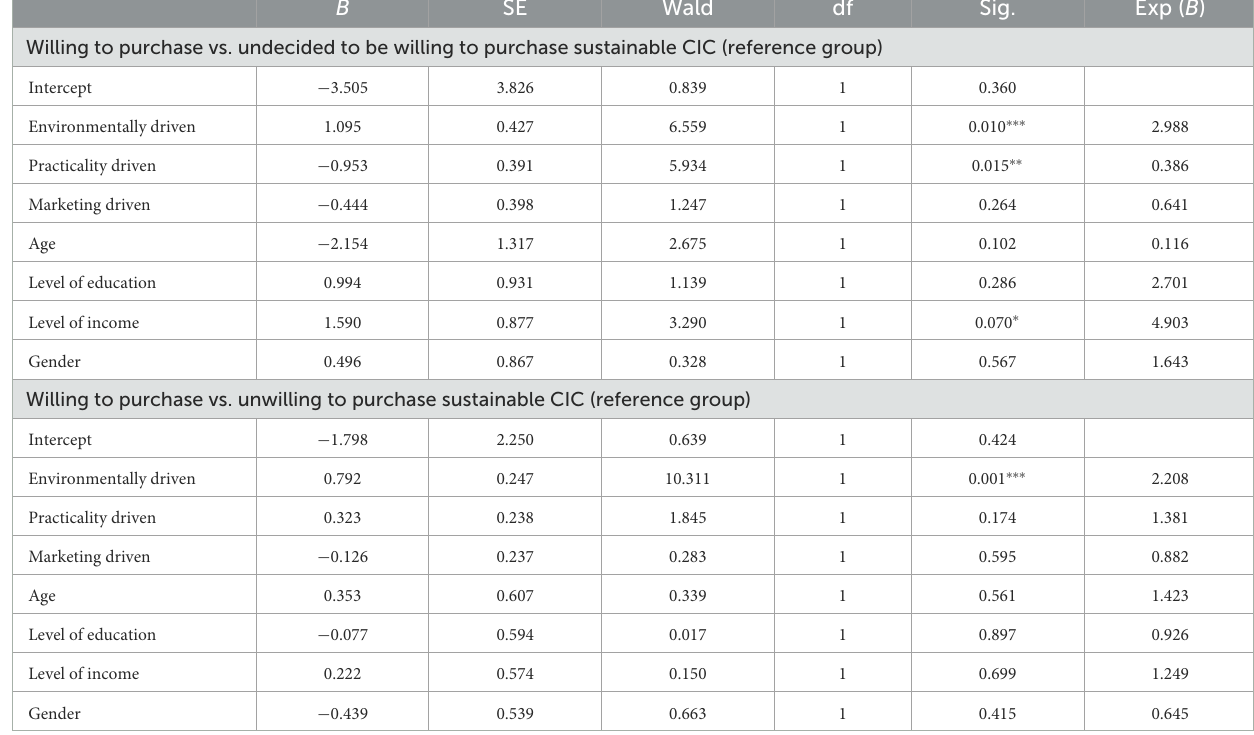
TABLE 3 Multinomial logistic regression. B SE Wald df Sig. Exp ( B